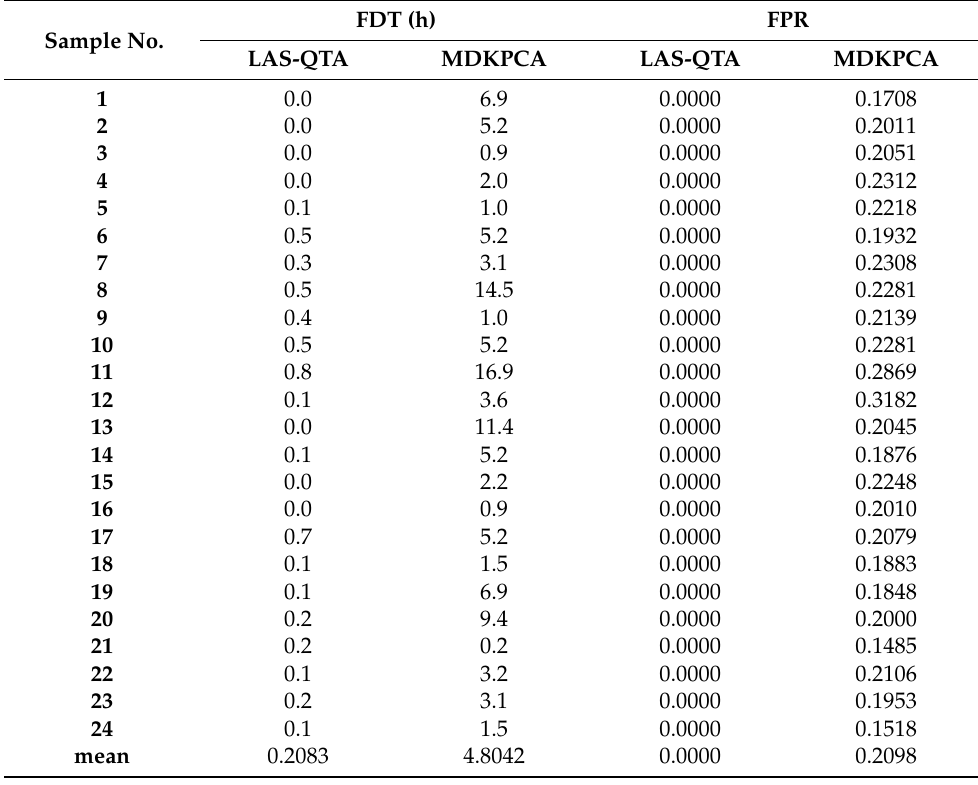
Table 5. The compared result between LAS-QTA and